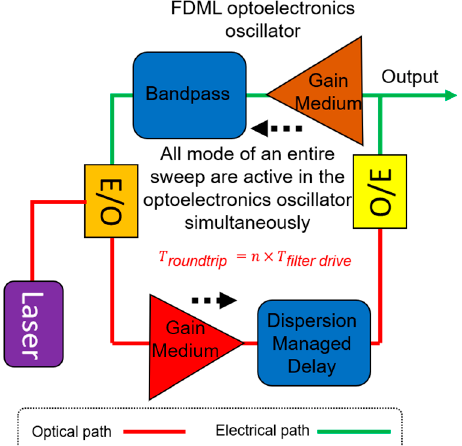
Figure 21. Schematic to show the operations of an OEO based on FDML oscillator. Adapted with permission from Ref. [152].